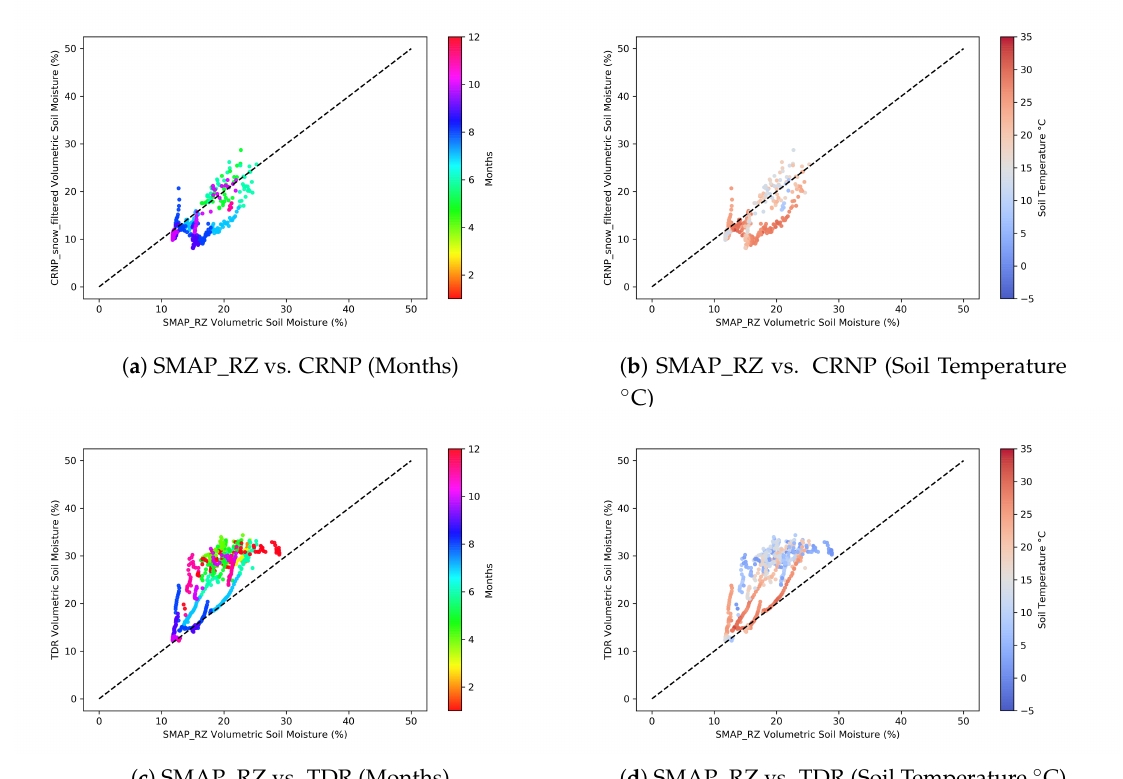
Figure A4. Comparisons between SMAP_RZ Soil Moisture Product with CRNP and